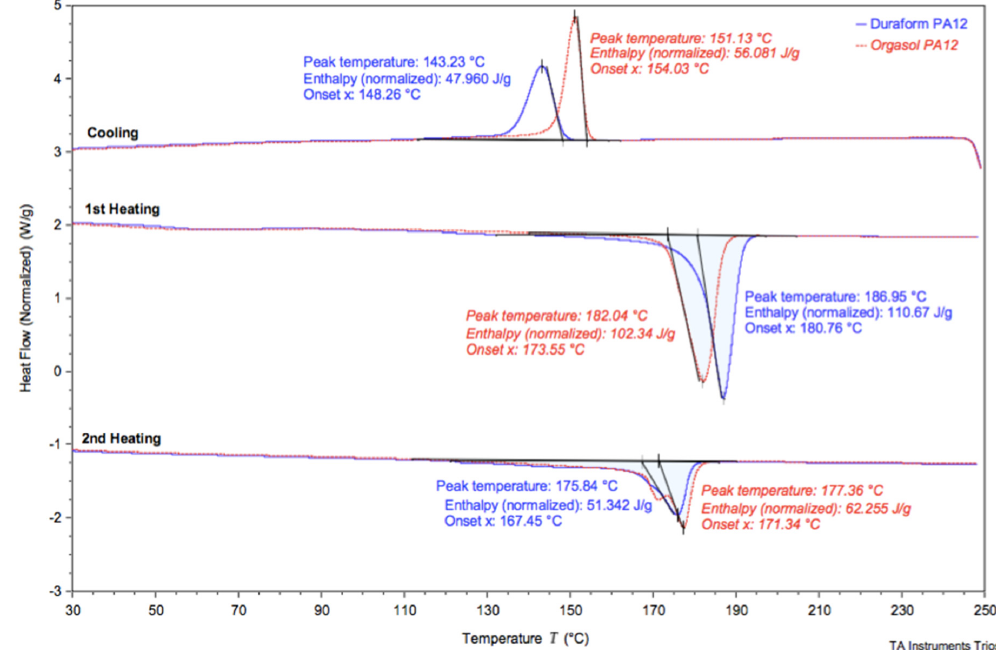
Figure 6. Comparison of the thermal behavior of Duraform ® PA (DF-PA) (blue) and Orgasol ® Invent Smooth (Orgasol-IS) (red) by thermal analysis (DSC).